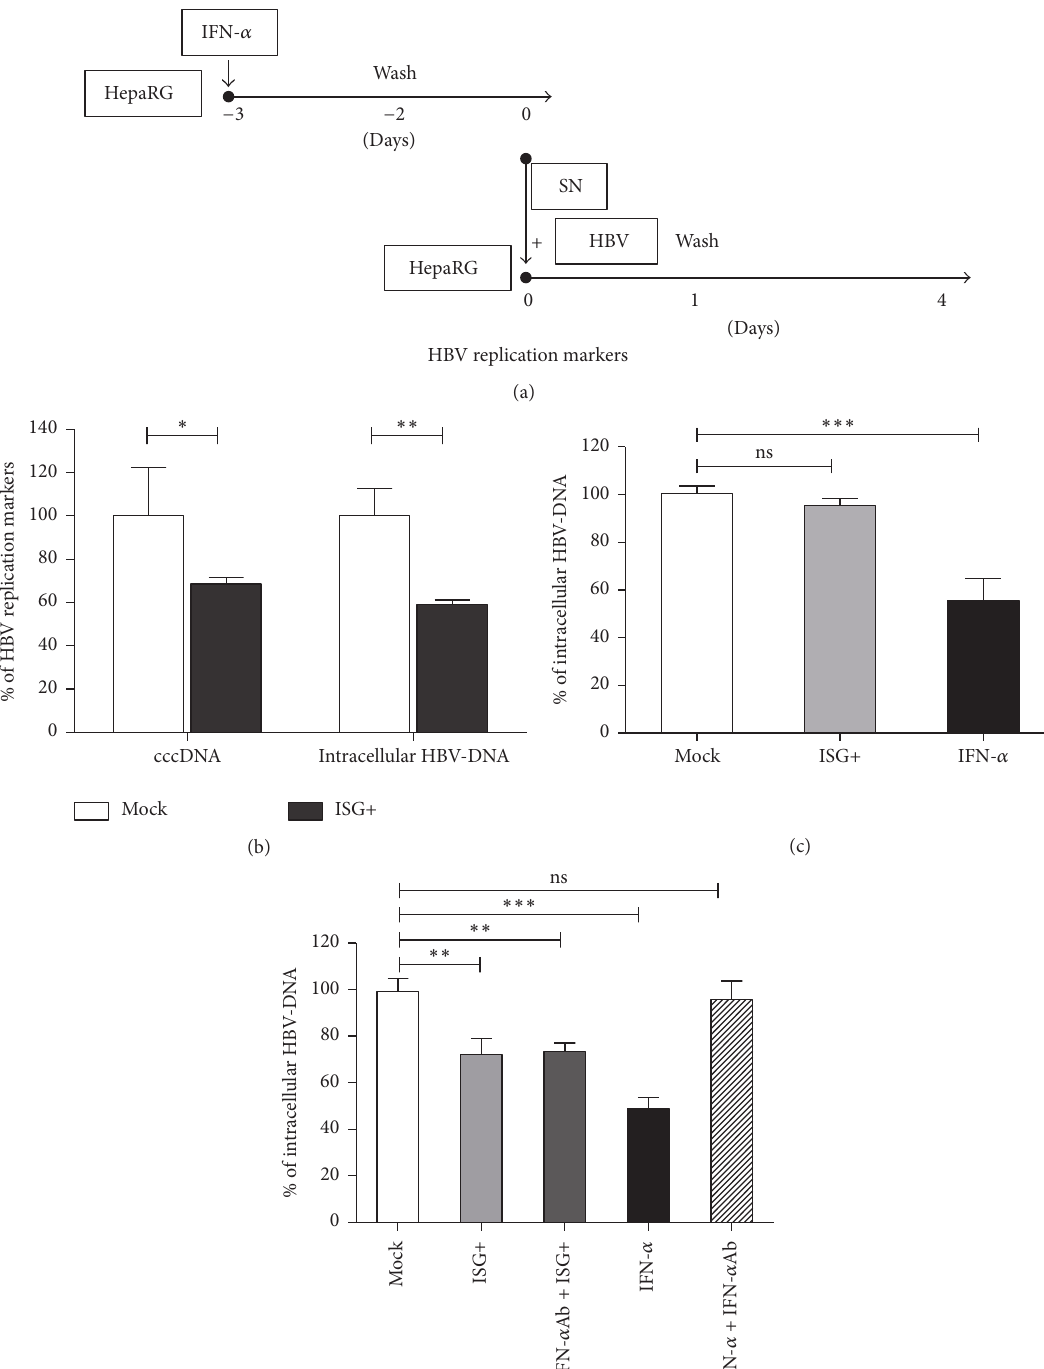
Figure 2: Secreted ISGs restrict early steps of HBV infection. (a) Differentiated HepaRG cells were treated with 1000IU/mL of IFN- 𝛼 . One day later, the medium was removed. Cells were washed three times with PBS and refilled with new medium. The resulting medium containing interferon induced factors (ISG+) was collected 48 hours later and then mixed with HBV and PEG. The mixture then transferred onto fresh differentiated HepaRG cell for HBV infection. (b) HBV cccDNA and intracellular DNA were evaluated by qPCR 4 days after infection. (c) Differentiated HepaRG cells were infected with HBV (MOI = 200) and 7 days later different treatments were applied as indicated. Intracellular HBV-DNA was measured 4 days after treatment. (d) Differentiated HepaRG cells were incubated with indicated treatment for 24 hours and then infected with HBV (MOI = 200). Intracellular HBV-DNA was measured 4 days after infection. Data are means ± s.d. ∗ 𝑃 < 0.05 , ∗∗ 𝑃 < 0.01 , and ∗∗∗ 𝑃 < 0.001 by Student’s unpaired two-tailed 𝑡